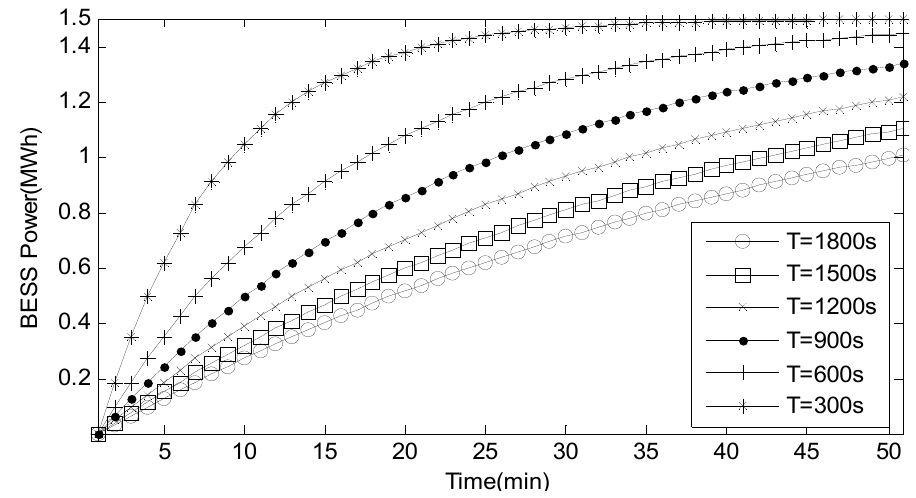
Figure 3. The relationship between the output power of BESS and time constant T .